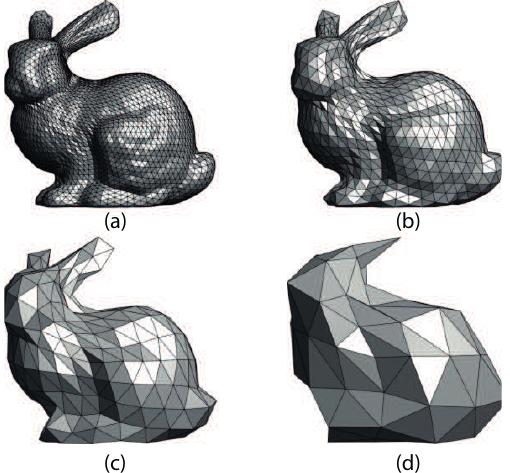
Figure 3. Wavelet decomposition of the semi-regular Bunny mesh: ( a ) dense mesh; ( b ) after one wavelet decomposition; ( c ) after two wavelet decompositions; ( d ) coarsest representation of